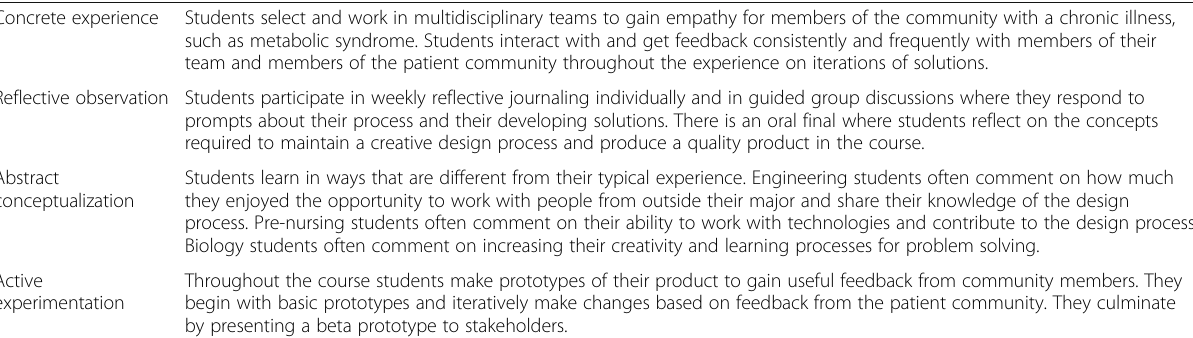
Table 2 Course activities aligned with the Kolb learning cycle (summarized from Nagel, Lewis, and Ludwig 2017) Concrete